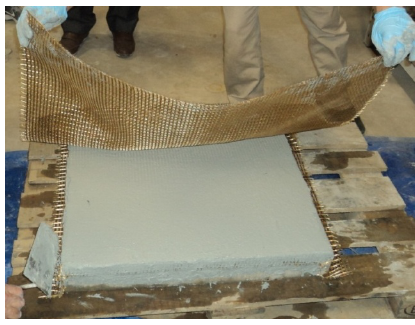
Figure 7: Application of the first layer of PBO Figure 8: Drawing up of the first mortar layer 4 mm